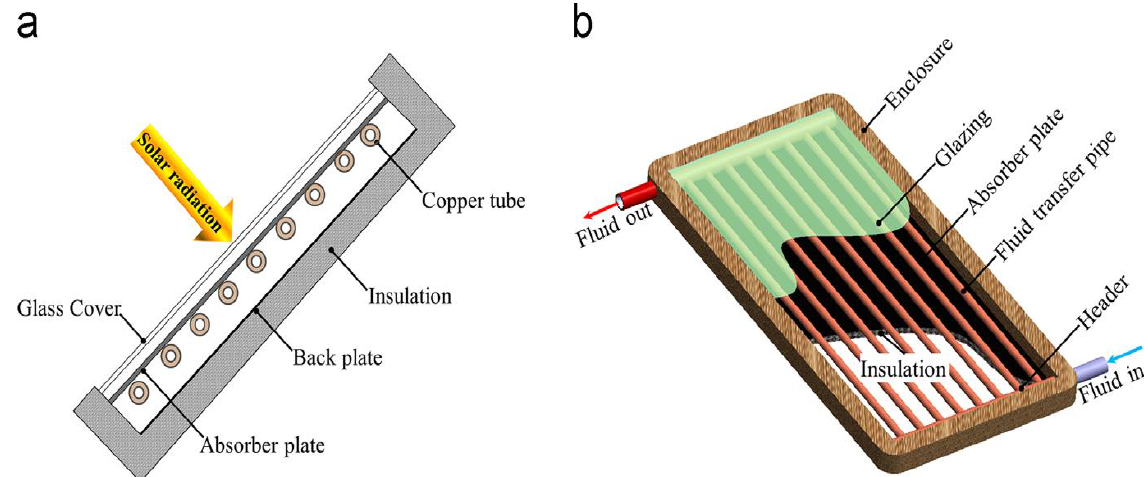
Figure 5. Flat plate collector construction ( a ) end view and ( b ) isometric view [35]